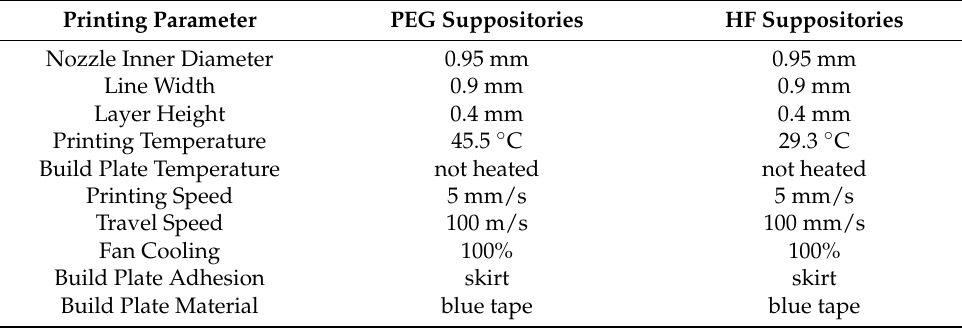
Table 2. Developed parameters of the 3D printing